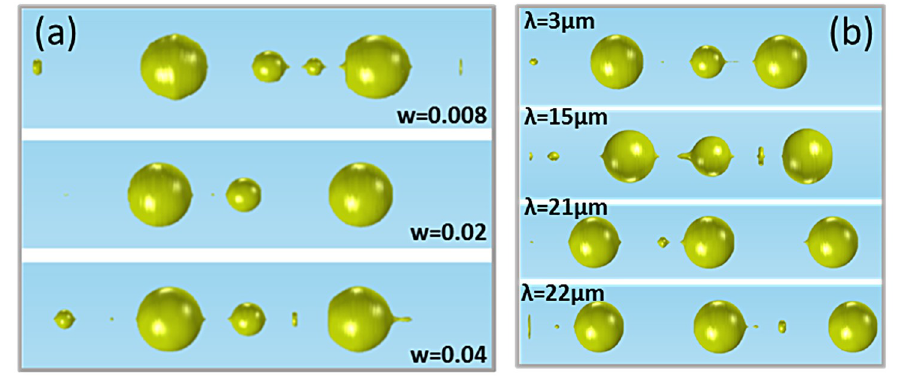
Figure 8. ( a ) The resulting topology of a 2 µ m radius gold core for di ff erent widths of the surface tension. ( b ) The resulting topology of a 2 µ m radius gold core for di ff erent wavelengths of the surface tension.